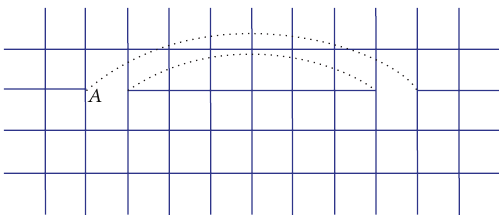
Figure 1: Schematic picture for nonlocal links on a regular lattice. The lattice represents space-time. The link, which represents a defect in the regularity of the background, is long according to the distance measure of the background. Note that all nodes remain 4-valent. If space-time is fundamentally discrete, similar defects should be all around